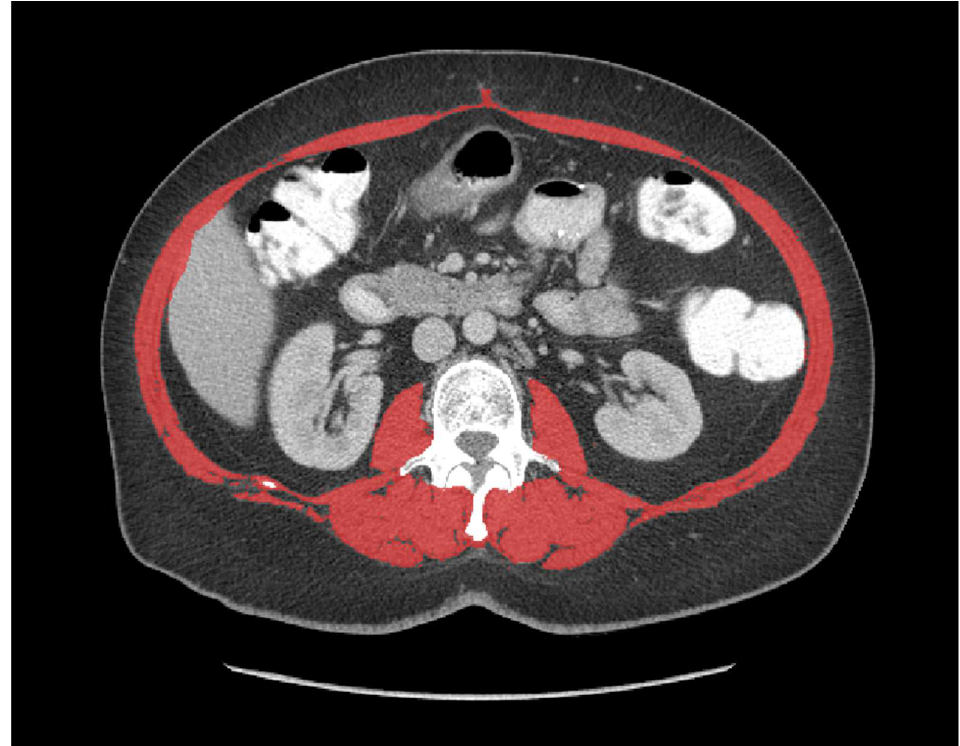
Figure 1. Muscle surface area measurement using an axial slice at L3. Muscles targeted included psoas, erector spinae, quadratus lumborum, transversus abdominus, external and internal obliques, and rectus abdominus muscles using a threshold of −29 to +150 HU (red).